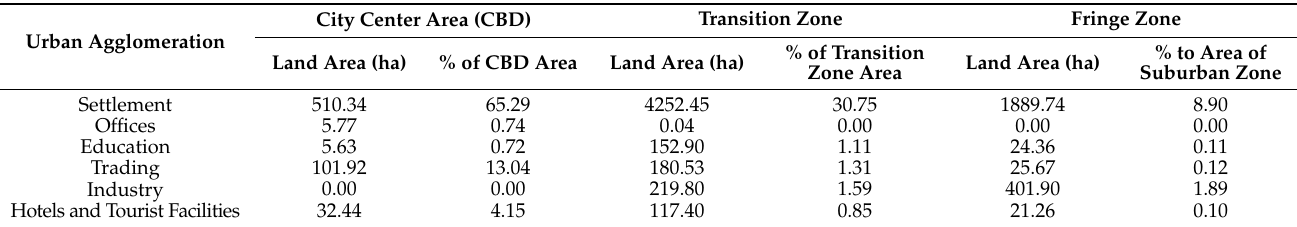
Table 6. Comparison of urban agglomerations based on spatial zones in Makassar City.